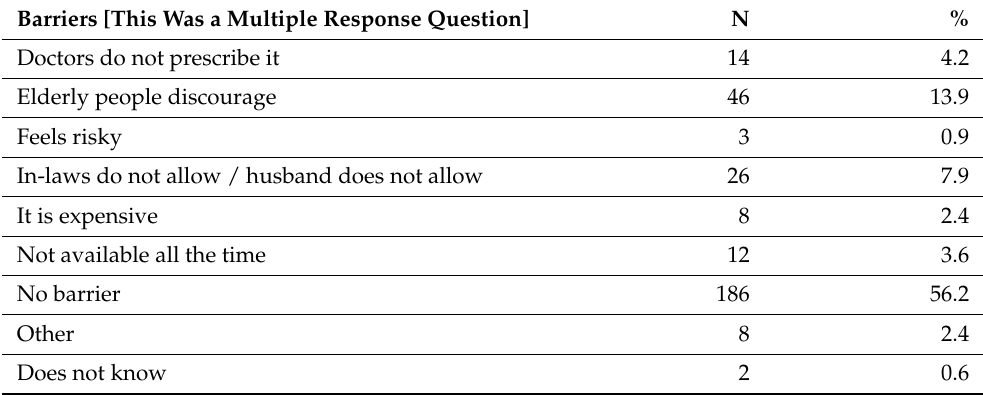
Table 8. Perceptions about the barriers to women consuming pregnancy